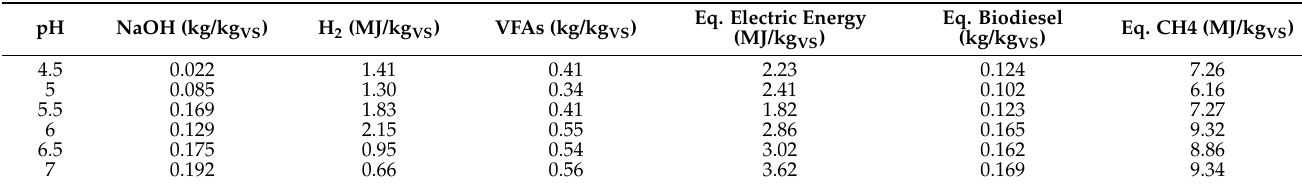
Table 4. Consumed NaOH, produced H 2 and VFAs followed by the equivalents of VFAs conversion through MFC, biodiesel production and anaerobic digestion, for the pH values examined in dark fermentation, per kg of VS of substrate used in the dark fermentation